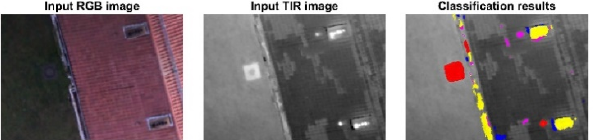
Table 4 Classes distribution in the datasets